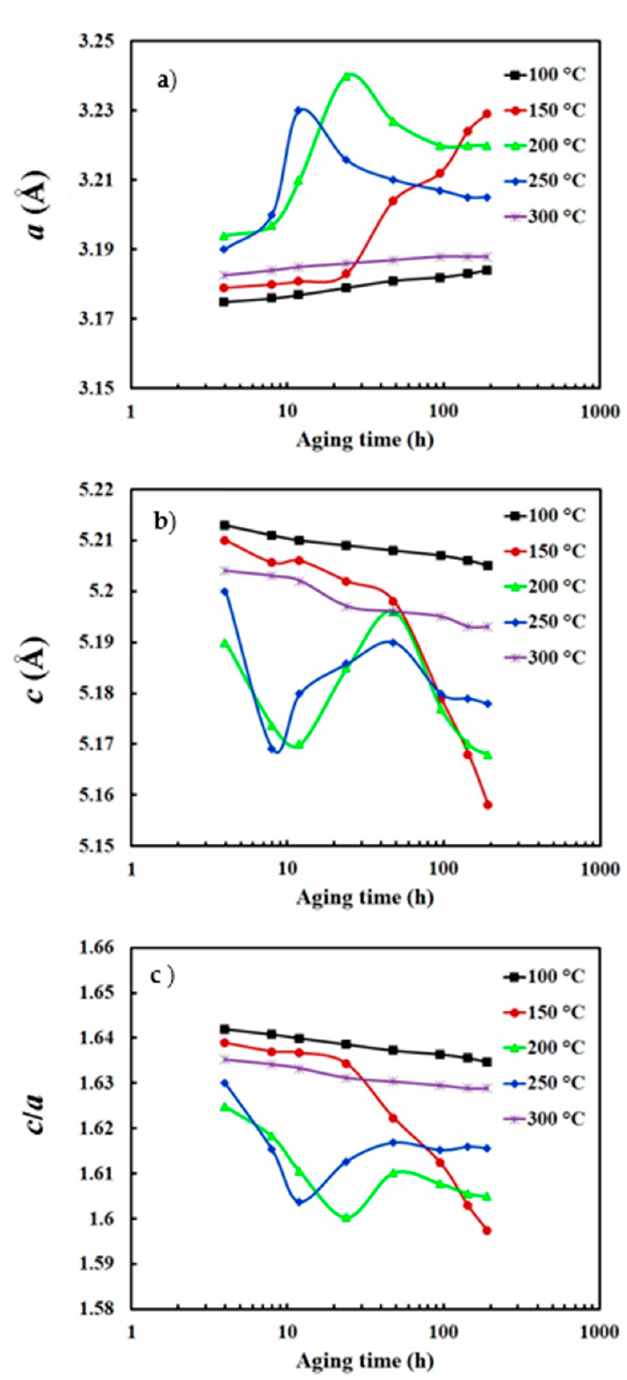
Figure 9. The variation of ( a ) the lattice parameter a , ( b ) the lattice parameter c , and ( c ) c / a ratio with the aging time for all the investigated samples aged at different temperatures.